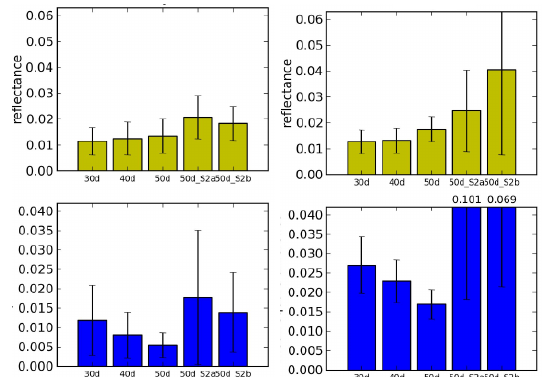
Figure 6. Fidelity (top) and artifact (down) performances for two locations, in Morocco during a cloud free period (left) and in south of France during a rather cloudy period (right), for the Near infrared band. Different test cases were compared, using both Sentinel-2A and 2B with periods of 30 days (30d), 40 days (40d), 50 days (50d), 50 days with S2A only (50d S2A), and 50